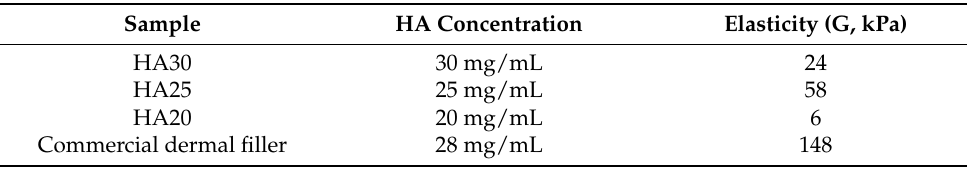
Table 2. Elasticity (elastic modulus) from extensional measures.